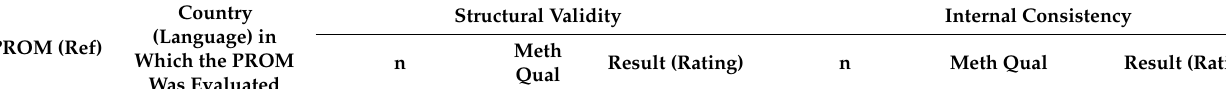
Table 8. Results of studies on measurement properties